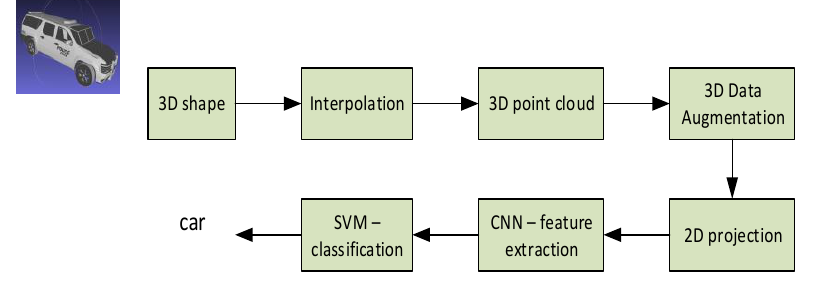
Figure 2. The proposed method.